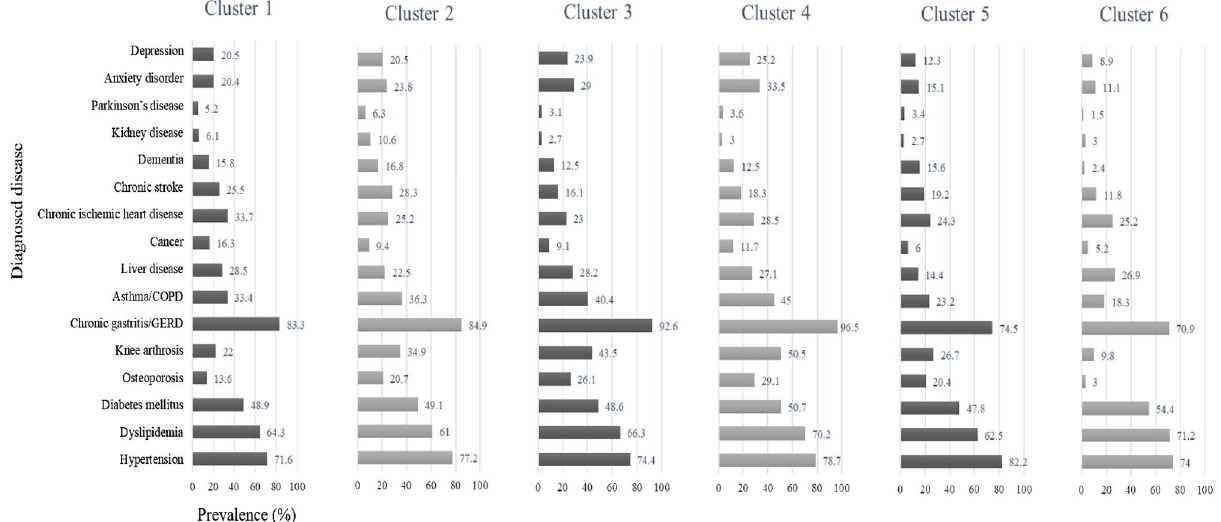
Figure 3. Comparison of diagnosed diseases in six clusters of study patients with polypharmacy. To compare the diagnosed diseases of patients in each cluster, they were evaluated by chi-square test and described by cluster (all P < 0.001). GERD gastroesophageal reflux disease, COPD chronic obstructive pulmonary